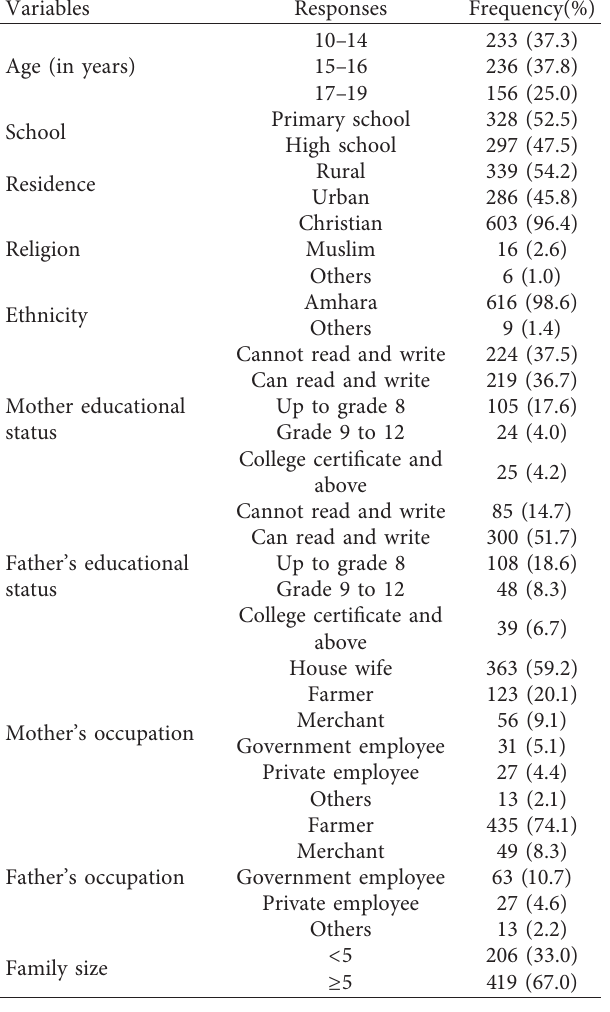
Table 2: Prevalence of goiter, malnutrition, and dietary practices of study participants, 2019.